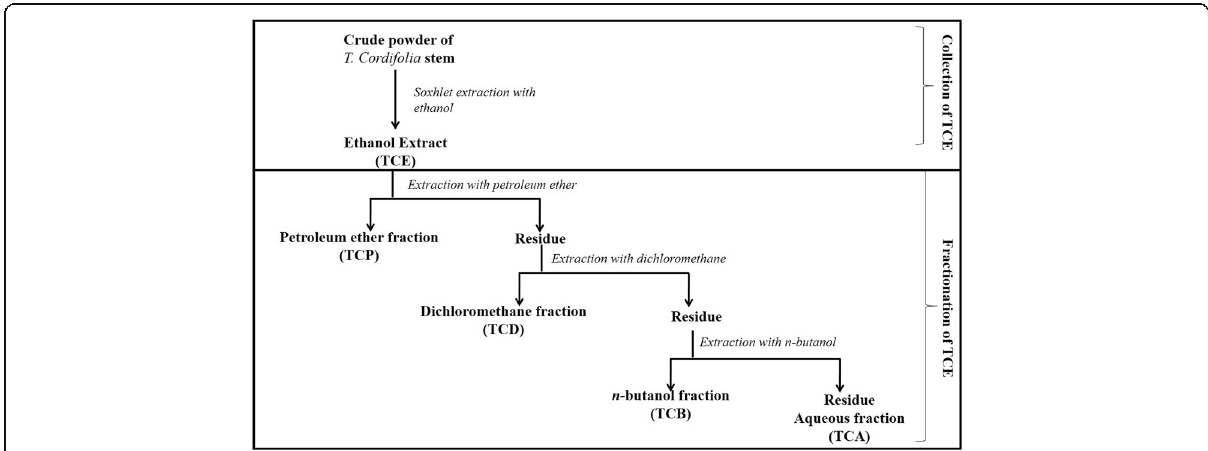
Fig. 1 Schematic representation of extraction and fractionation of T